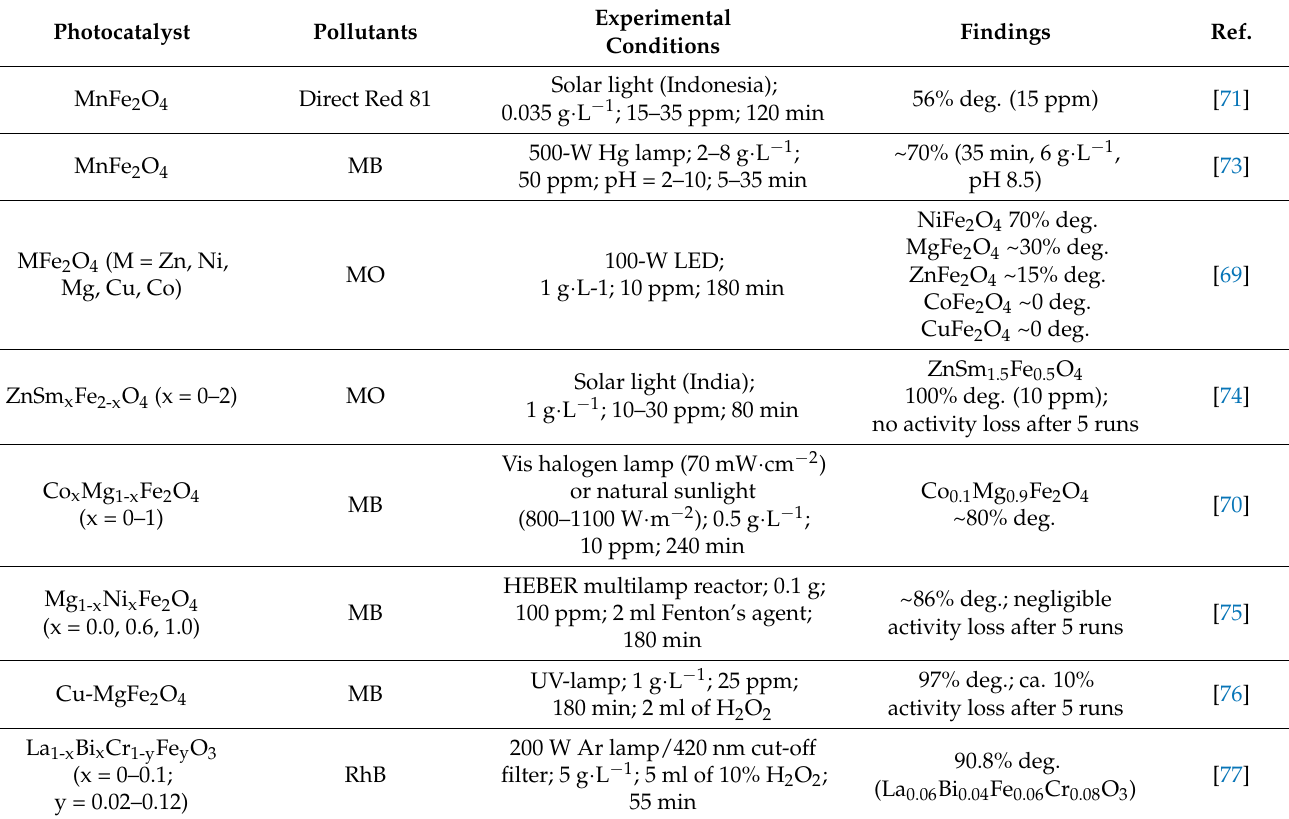
Table 1. Summary of photocatalytic activity on spinel ferrites.